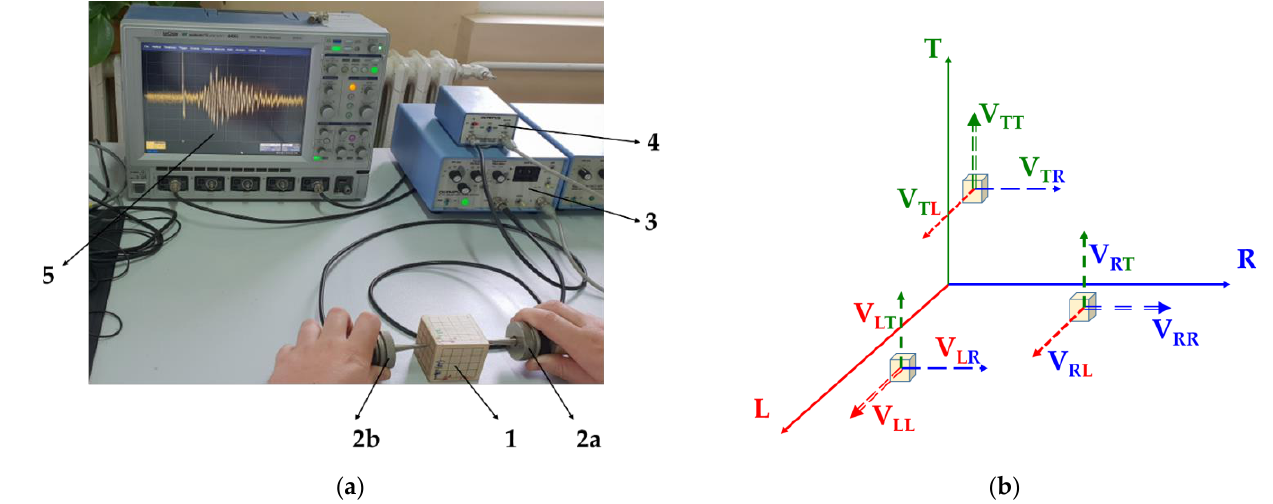
Figure 3. Experimental set-up. ( a ) The principles of ultrasound measurements. Legend: 1, sample; 2, US sensors (emis- sion/reception transducers); 3, Pulse Receiver – Panametrics equipment; 4, conditioner; 5, digital oscilloscope. ( b ) Ultrasonic velocity in wood [12,13].